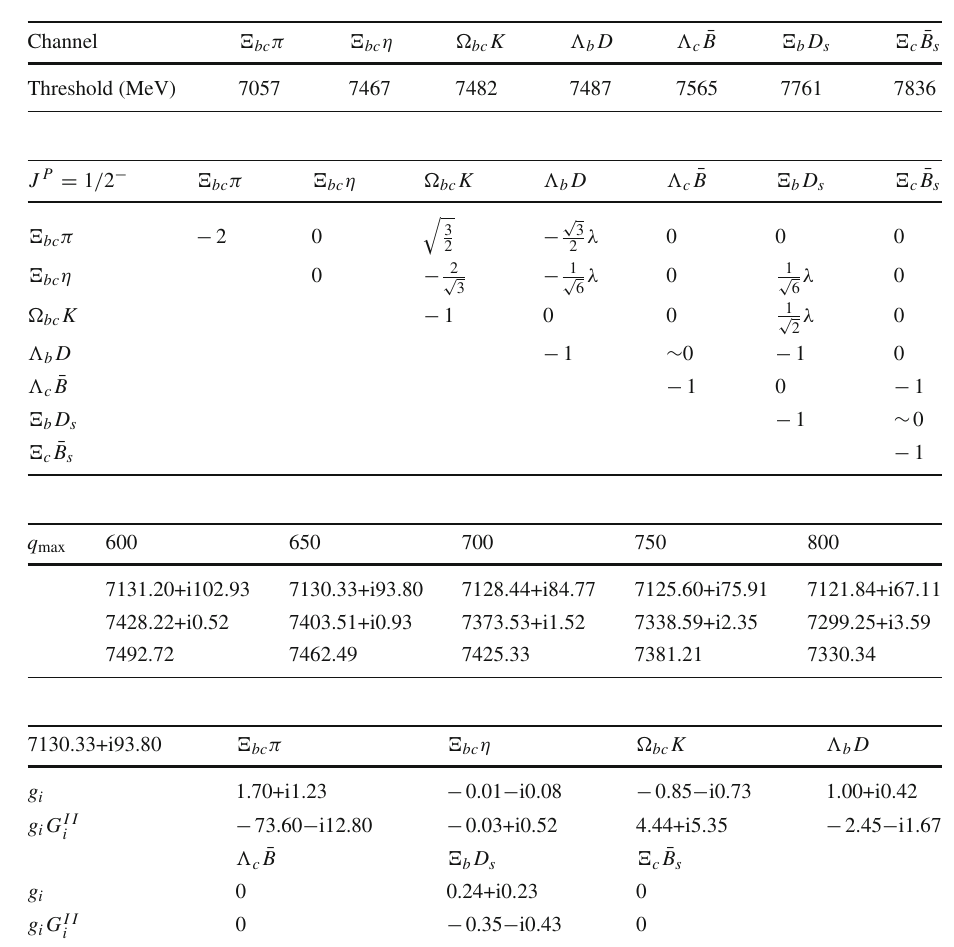
various channels and g i G II MeV with q max =